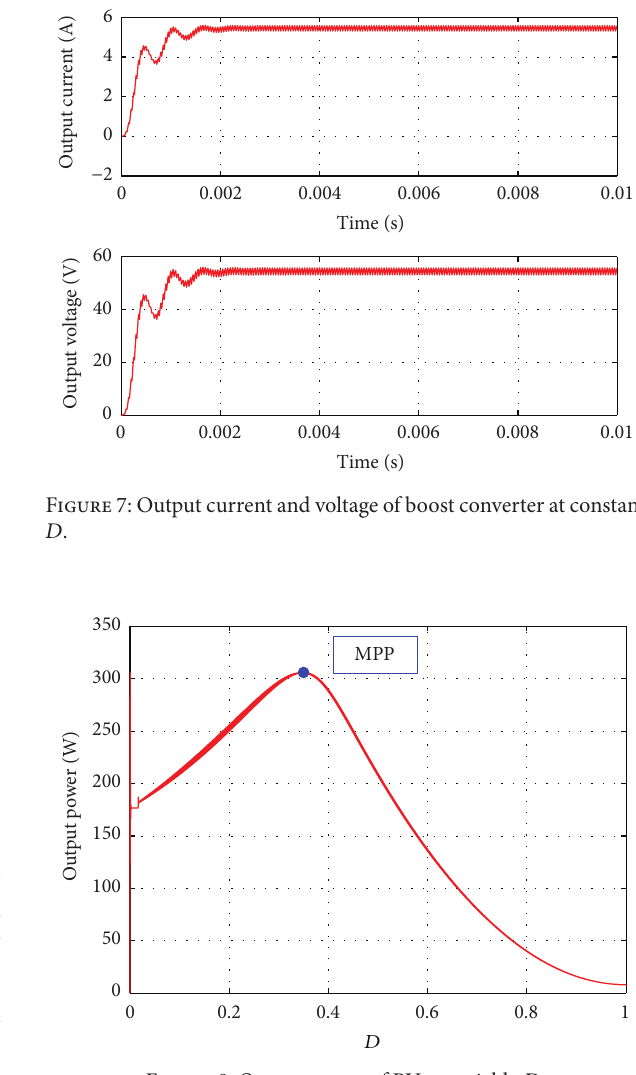
Figure 8: Output power of PV at variable 𝐷